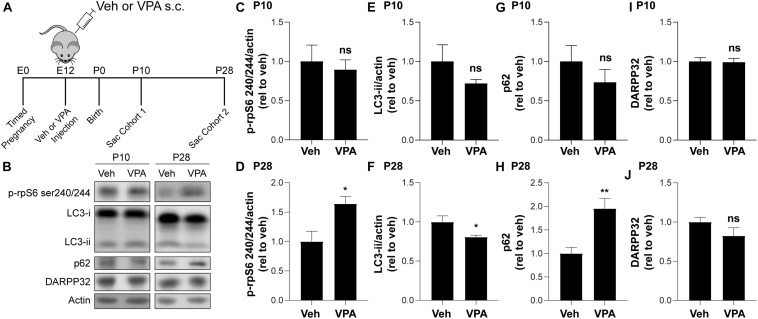
VPA reduces autophagy at P28. (A) Schematic of VPA administration. (B) Representative Western blot images for LC3B, p62, p-rpS6 S240/244, DARPP32, and actin. (B–G) Quantification of (B–D) p-rpS6 S240/244 relative to actin, (B,E,F) LC3B-ii relative to actin (B,G,H) p62 and (B,I,J) DARPP32 normalized to VPA untreated (veh, vehicle) mice at P10 and P28, respectively. Data analyzed with unpaired, two-tailed t-test; (C) p-rpS6 S240/244/actin at P10, ns; (D) p-rpS6 S240/244/actin at P28, t11 = 2.882, p = 0.0149 (E) LC3B-ii/actin at P10, ns; (F) LC3B-ii/actin at P28, t10 = 2.231, p = 0.047; (G) p62 at P10, ns; (H) p62 at P28, t10 = 3.752, p = 0.0038; (I) DARPP32 at P10, ns, and (J) DARPP32 at P10, ns, *p < 0.05, **p < 0.01, ns not significant, n = 4–7 mice/treatment.